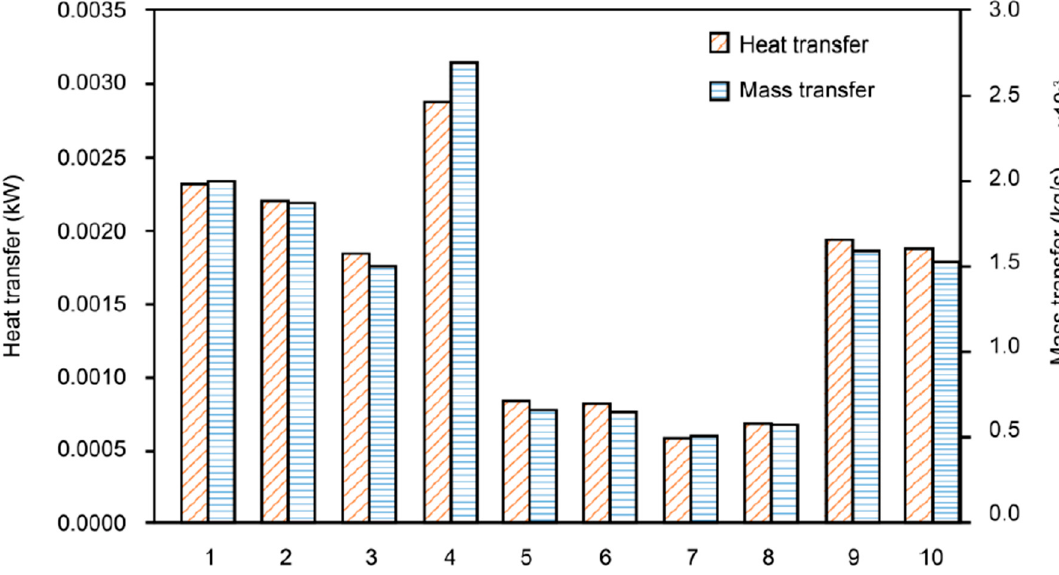
. . Q ) and mass transfer (mass flow rate, m ) among